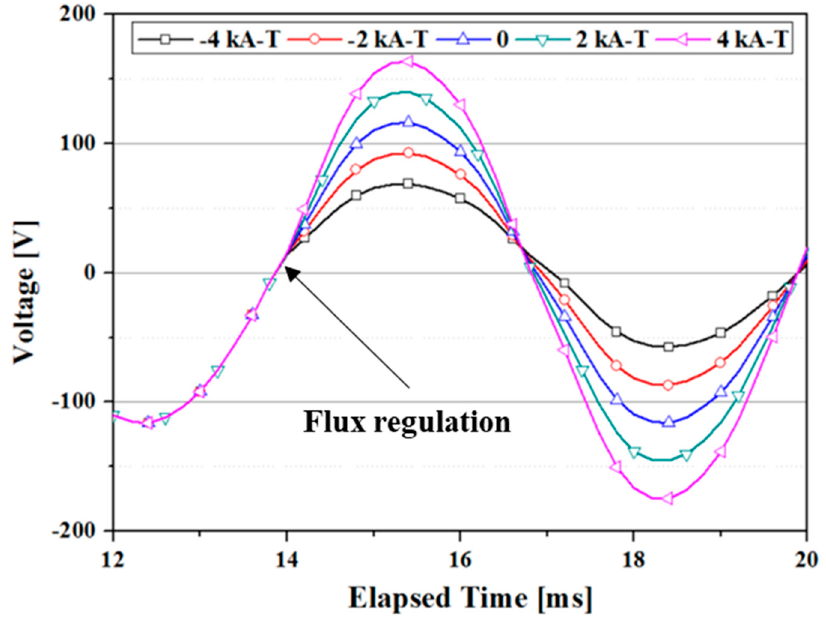
Figure 20. Phase voltage of Phase C in the resistance-load condition according to the MMF of the additional field winding.